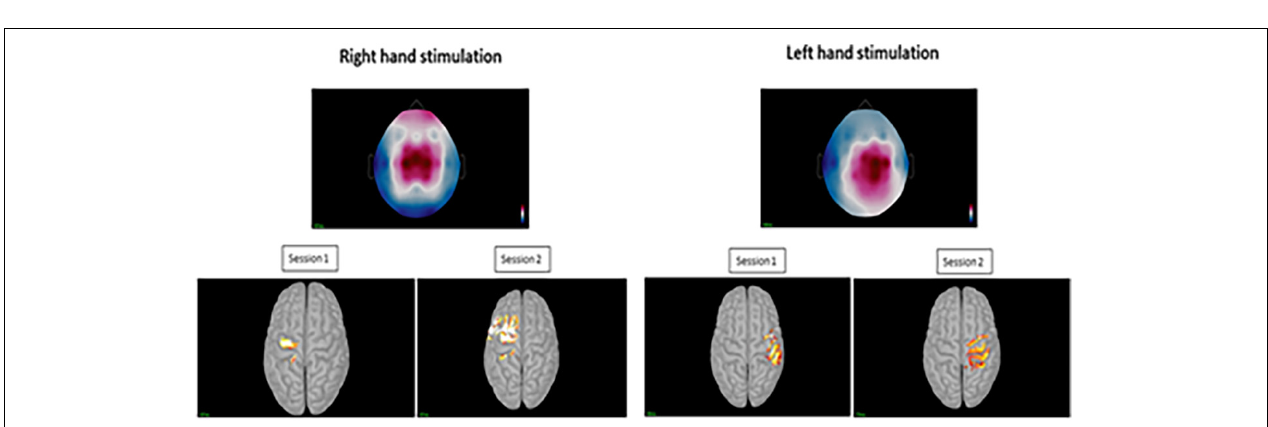
FIGURE 4 | Averaged ERS/ERD plots for all participants during right and left hand pin-prick stimulation at the respective C3 and C4 channels.